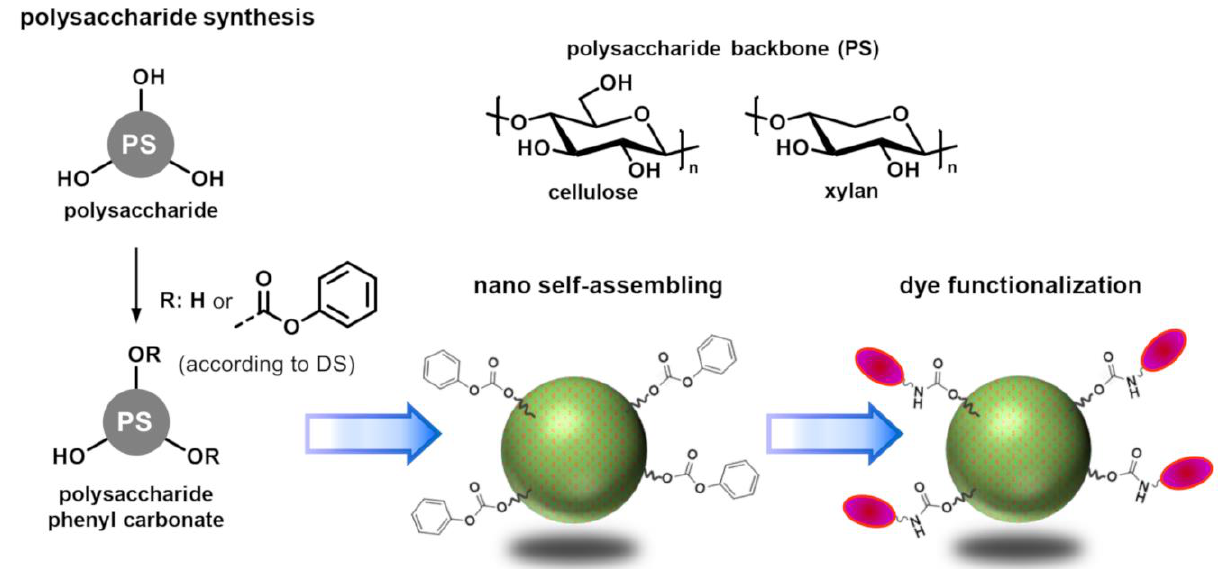
Figure 1. Scheme for the synthesis of polysaccharide phenyl carbonates as well as for the subsequent formation and dye functionalization of reactive nanoparticles.